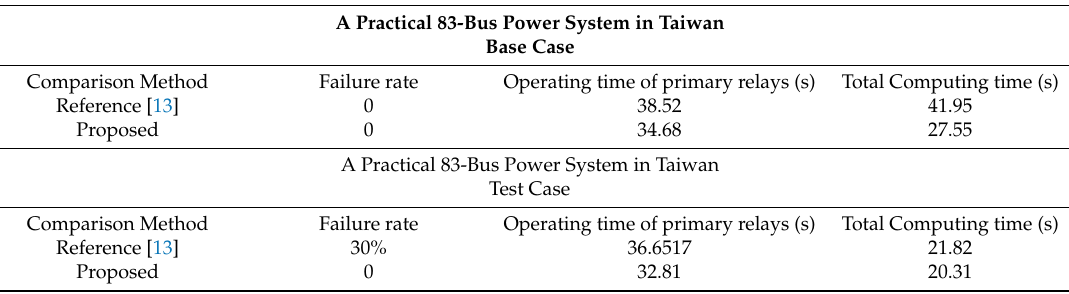
Table 2. Sixteen conditions considered for system